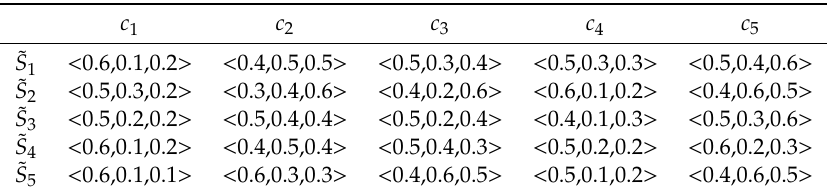
Table 2. Normalized decision matrix.